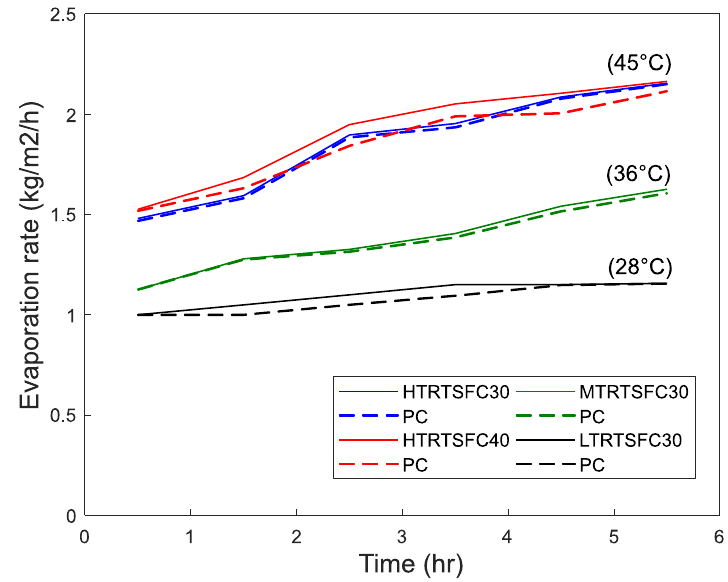
Figure 8. Effect of temperature on evaporation rates (wind speed = 4.7 m/s).